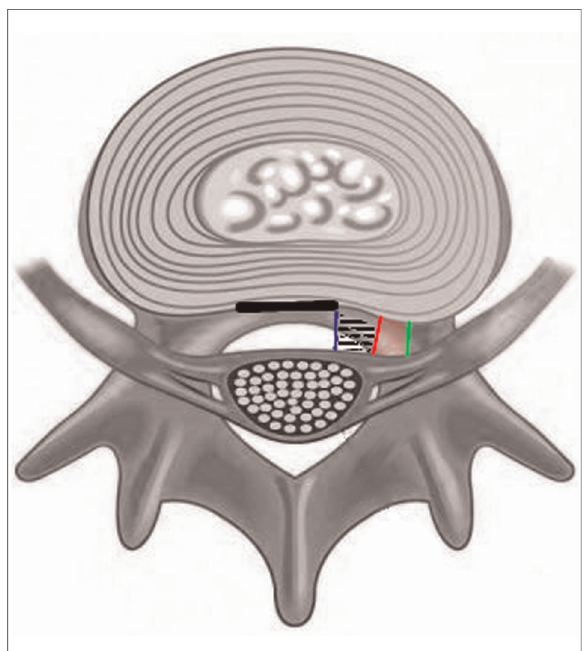
FIGURE 2 Schematic drawing presenting location and attachments of the ligaments on the axial cut of the spinal canal. Thick dark line — posterior longitudinal ligament, blue line — medial MVL, red line — lateral MVL, green line — radicular MVL, black dashed area — medial part of the anterior epidural space, red area — lateral part of the anterior epidural